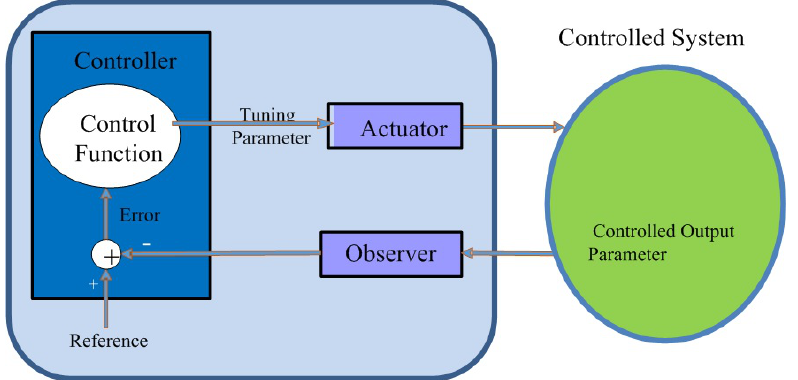
Figure 2. Feedback control system for the DFBCP